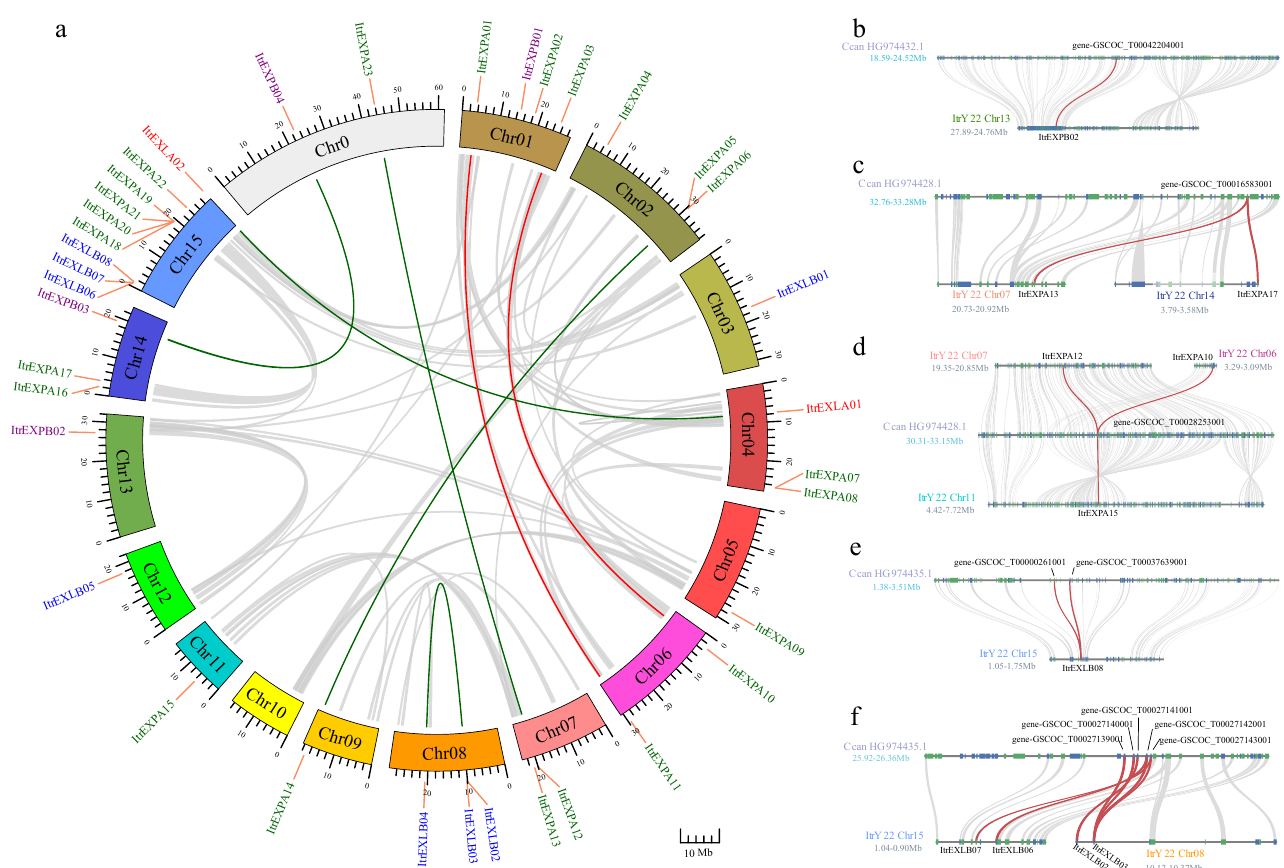
Figure 2. Chromosomal distribution and syntenic relationships of Y22 ItrEXPs . ( a ) The syntenic relationships of ItrEXPs in Y22 genome. The Chr0 means the scaffold that is unanchored to the chromosome level. The gray lines show the syntenic regions. The genes located in syntenic regions are marked with red lines; otherwise, they are marked with green lines. ( b – f ) Microsynteny analysis of expansin genes between the Y22 and C. canephora genomes. The expansin genes and their orthologous syntenic genes in C. canephora are linked by red lines, and the others are linked by gray lines. One-to- one, one-to-two, one-to-three, two-to-one and four-to-one syntenic genes between C. canephora and Y22 genomes are shown in ( b ), ( c ), ( d ), ( e ), and ( f ),